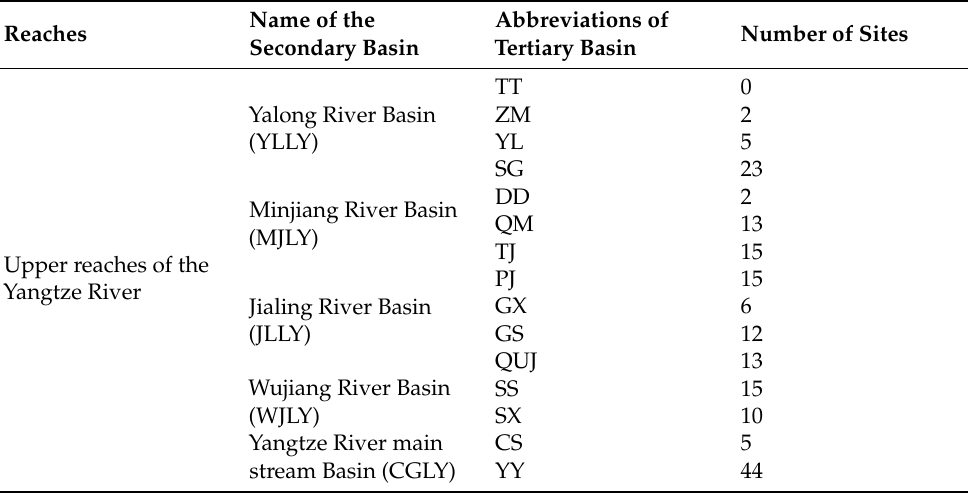
Figure 2. Map of the study area, including the distribution of secondary, tertiary, and water quality monitoring stations. Table 1. Names, affiliations, number of monitoring sites, and measured turbidity of 3 rivers reach 9 second-level watersheds and 45 third-level.